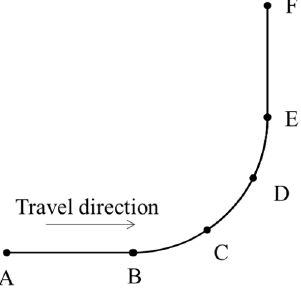
Figure 8 Curve segments